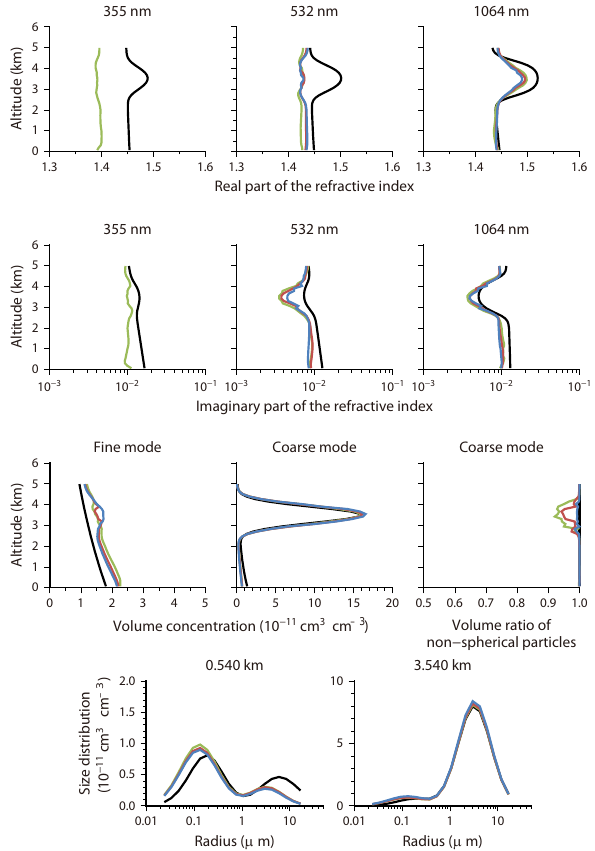
Figure 8. Retrieval results from the simulated data for the trans- ported dust: the real and imaginary parts of the refractive index, the volume concentrations of the fine and coarse modes, the volume ratio of the non-spherical particles to total particles in the coarse mode, and the size distributions at two altitudes. “True” values are shown by the black lines, the colored lines indicate retrievals from Type 1 data set (MIEL data at 532 and 1064nm) (blue), Type 2 data set (MIEL data at 532 and 1064nm; HSRL data at 532nm) (red), and Type 3 data set (MIEL data at 532 and 1064nm; HSRL data at 355 and 532nm) (green).